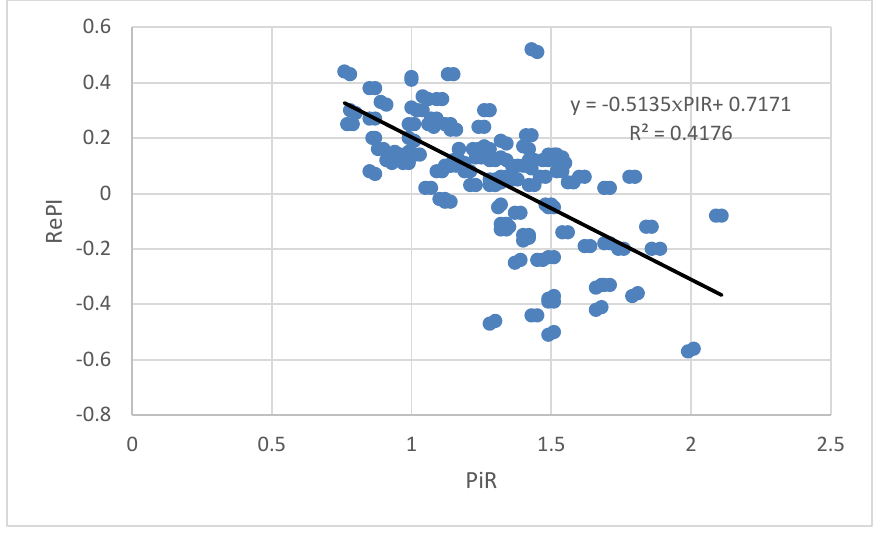
Figure 2 . Dependence of RePI from PIR. Black line represents linear approximation. Figure 2. Dependence of RePI from PIR. Black line represents linear